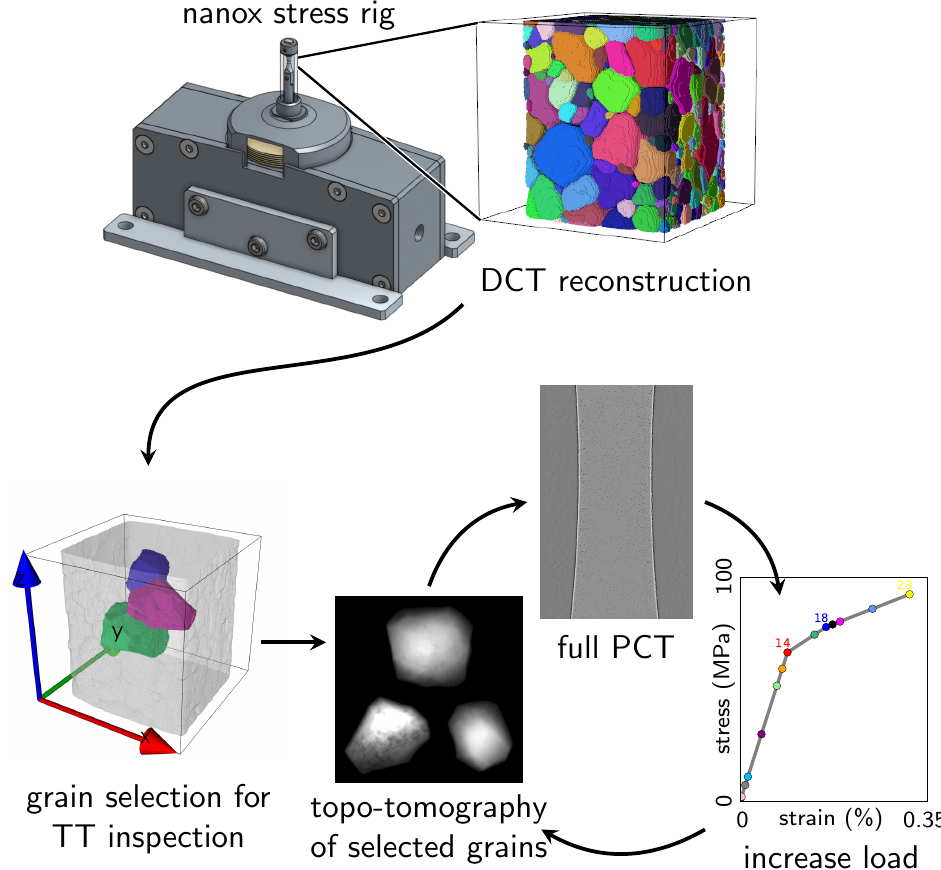
Figure 2. Sequence of the in situ topotomography experiment: the initial microstructure is characterized by DCT and analyzed after mounting the specimen into the Nanox device [15], then 23 complete sequences, each comprising three topotomography and one phase contrast tomography scan, have been recorded at increasing levels of load (the color code used in the tension curve is used later on to plot results at a given load